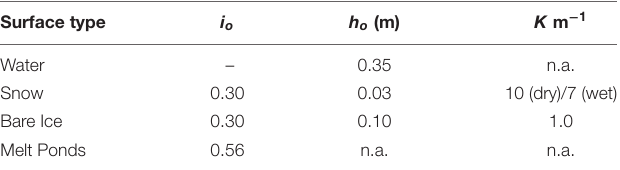
TABLE 1 | Values of the parameters used in this study (based on adjustment to Green Edge observations, see Lebrun, 2019). Surface type